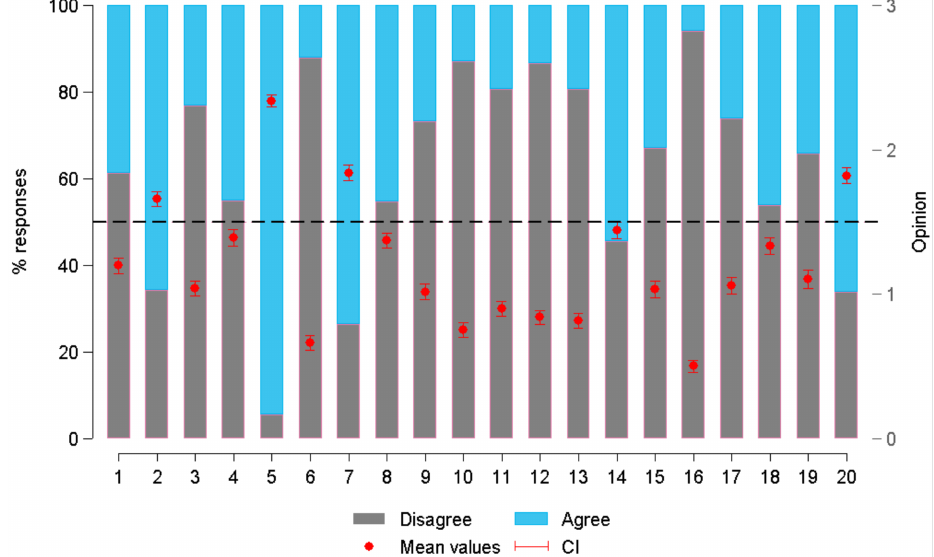
Figure 2. Percentage of responses that agree and disagree with each question and mean opinion values and their confidence